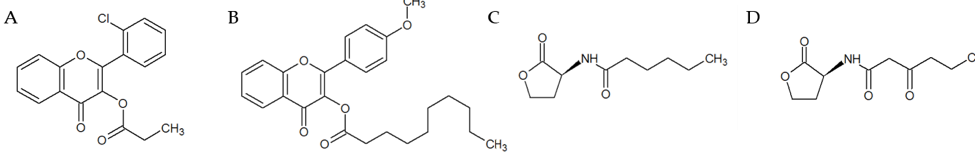
Figure 4. Structures of the lead compounds 2117 ( A ) and 2896 ( B ), N -hexanoyl- L -homoserine lactone (C6-HSL) ( C ), and autoinducer, N -( β -ketocaproyl)- L -homoserine used for C. violaceum CV026 cultures ( D ). The structures are drawn using ACD/ChemSketch software.